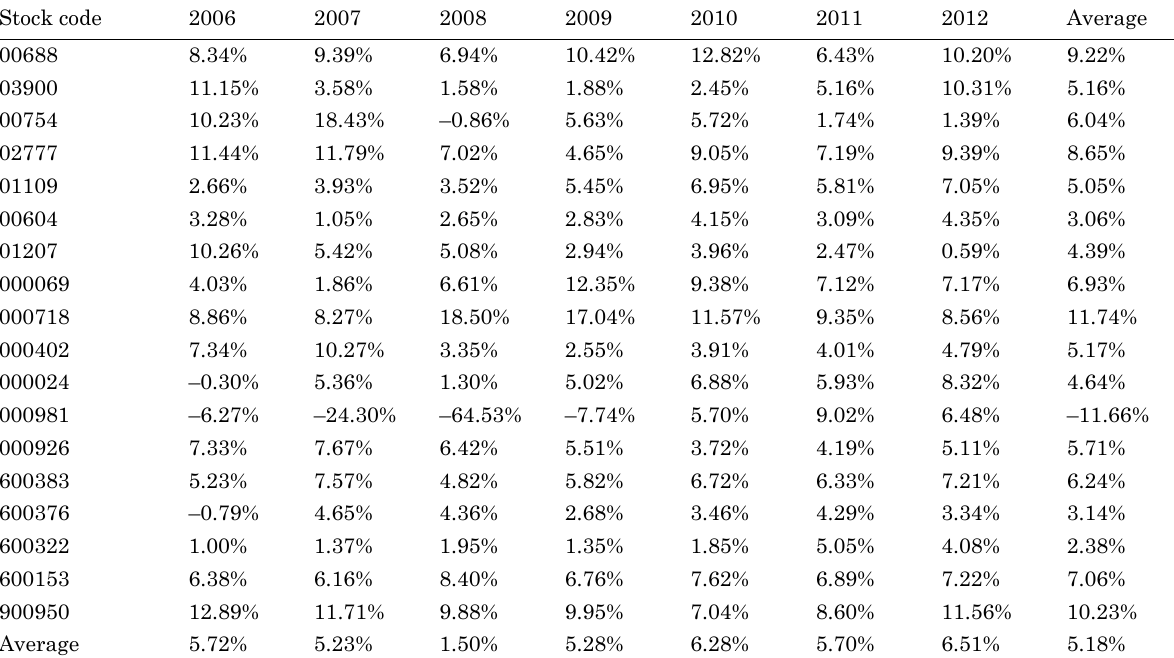
Table 4. ROIC of the 18 mainland property companies during the period 2006–2012 Stock code